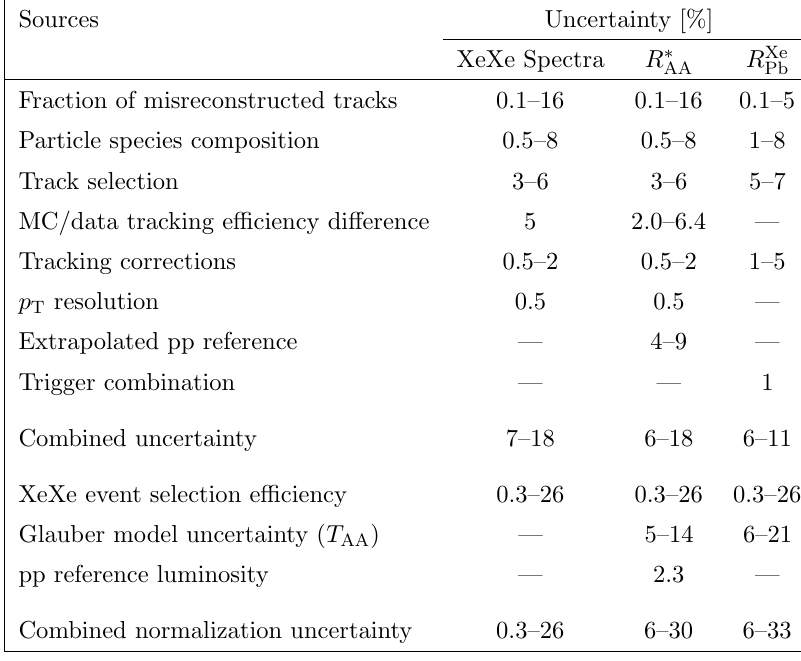
Table 2 . The systematic uncertainties related to the measurements reported here. The values quoted cover the centrality and p T dependence of each uncertainty. They are separated into nor- malization uncertainties and all other systematic